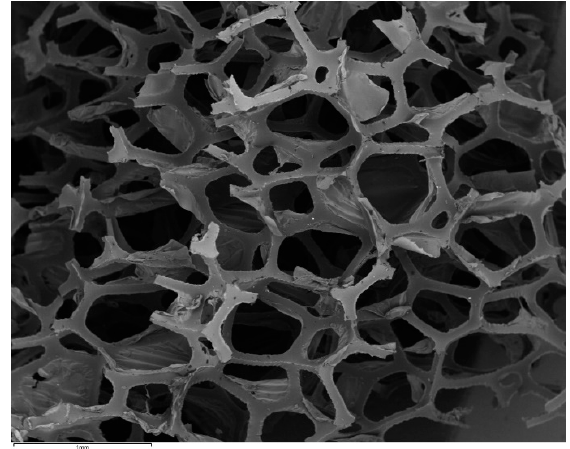
Figure 2. SEM image of the dishwasher sponge [12].